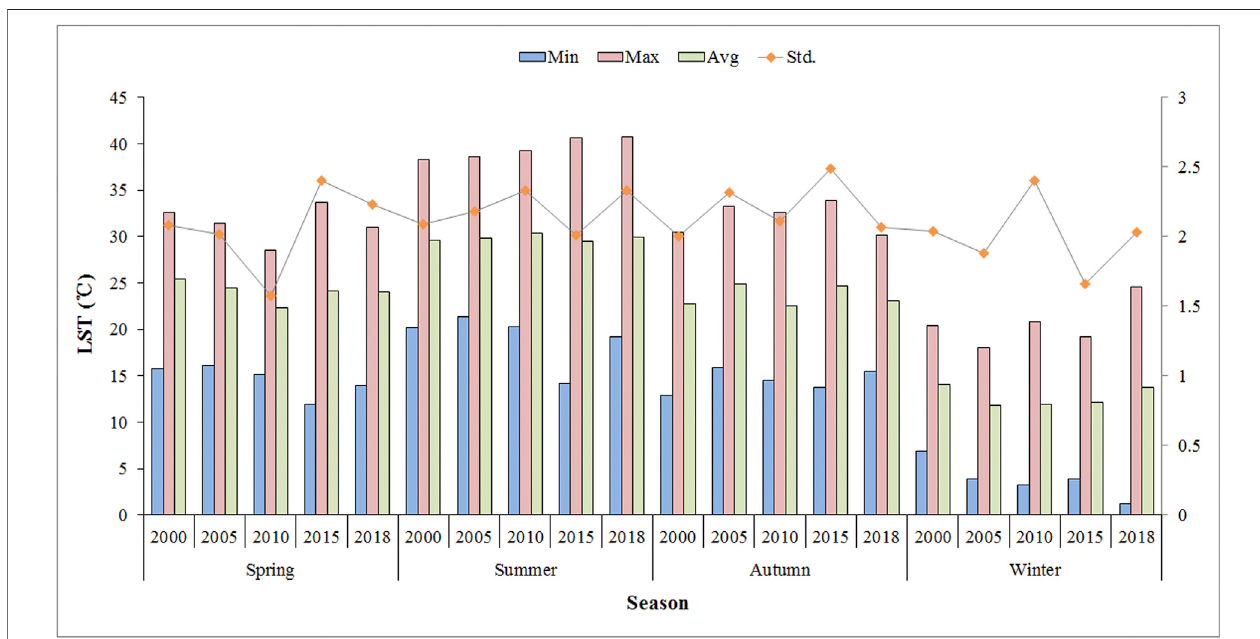
FIGURE 7 | Histogram of seasonal LST during the period 2000 – 2018 to evaluate the temperature change in each season.